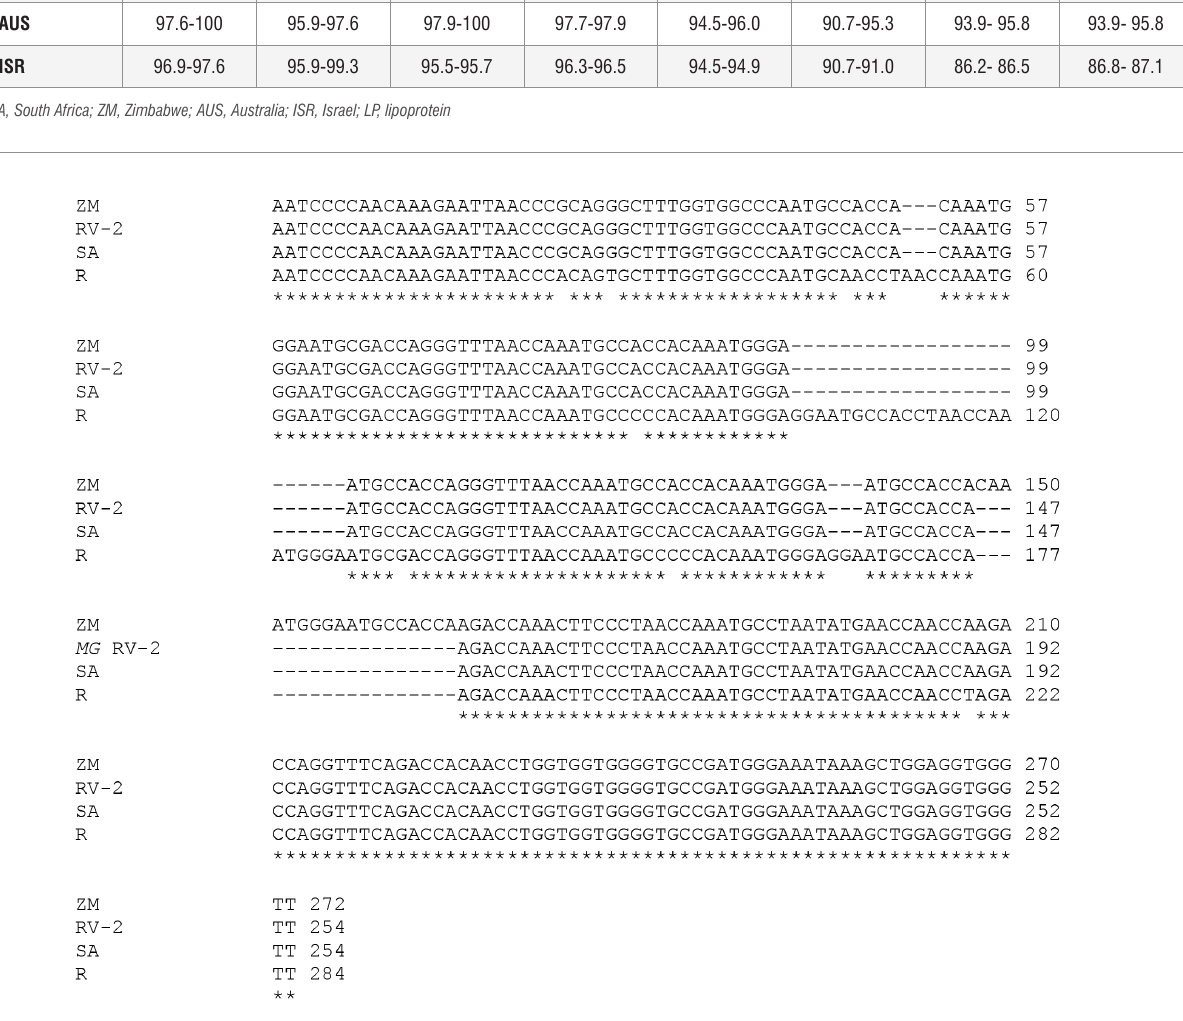
Figure 1: CLUSTAL W alignment of the partial mgc2 cytadhesin gene from the South African (SA) and Zimbabwean (ZM) field genotypes of interest compared with that of the RV­2 genotype (EU939449) showing closet percentage identity from nucleotide­nucleotide BLAST searches. The reference R genotype was also